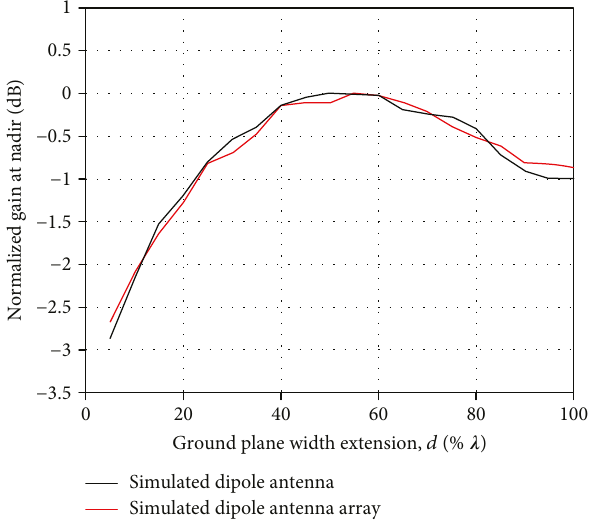
Figure 21: Comparing the ground plane width extension versus normalized gain at nadir for the single dipole element and array.